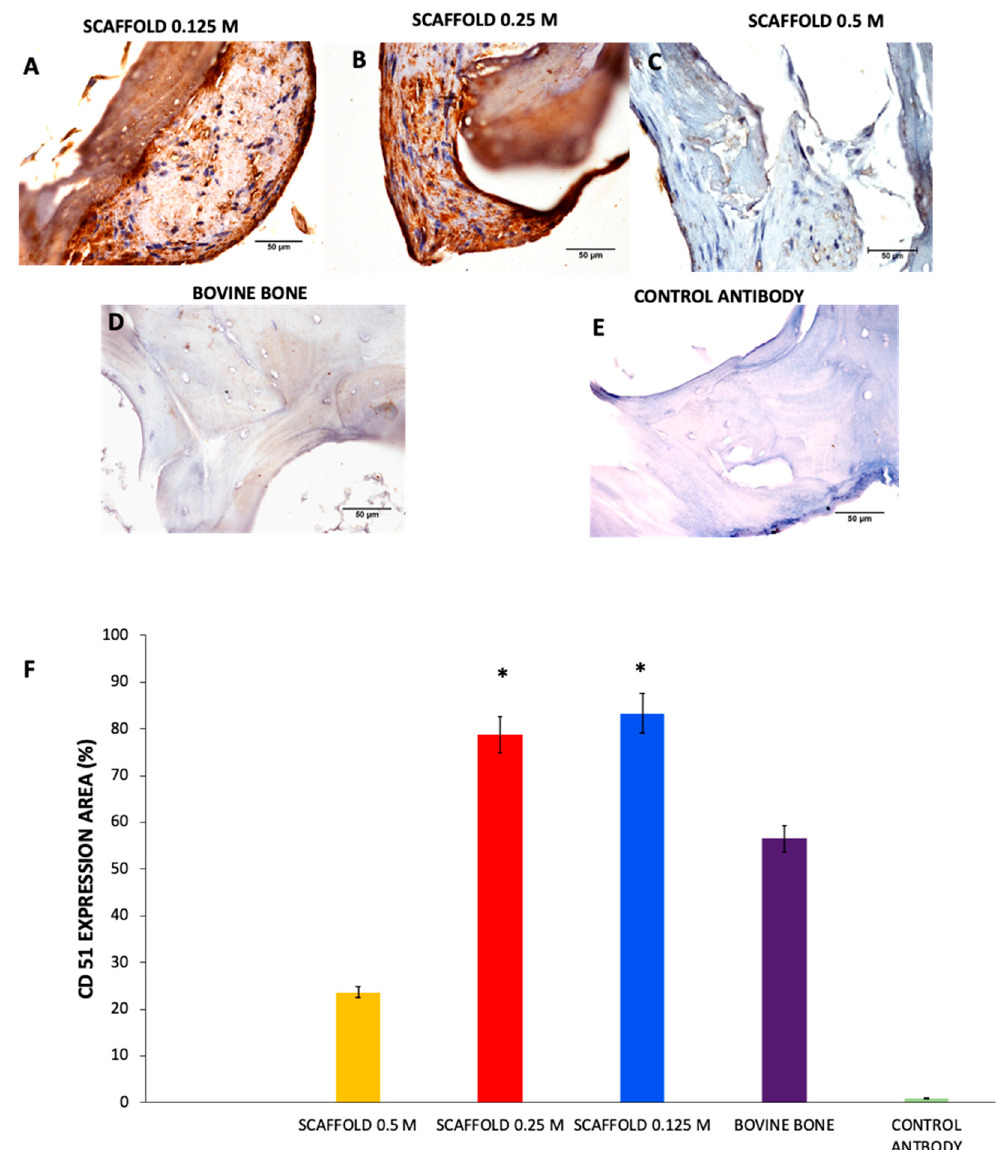
Figure 10. Immunohistochemical analysis in histological sections of the scaffolds and bovine bone immunolabeled with CD51 (brown). Scaffolds were positive to CD51 antibody staining in the 0.125 M ( A ), 0.25 M ( B ), and 0.5 M ( C ). As controls, we used bovine bone without decellularization process ( D ) and the bone without primary antibody ( E ). The CD51 expression area quantified was calculated by Image-pro software ( F ). The 0.125 M and 0.25 M scaffolds present significant differences compared to bovine bone and 0.5 M scaffold. * p < 0.0001, Mean ± SD n > 3. 40×, scale bar = 50 μ m.